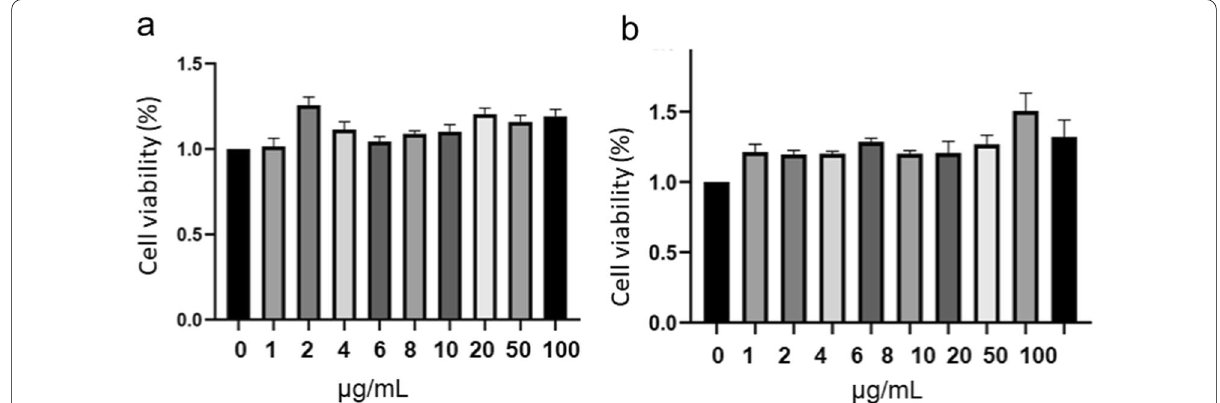
Fig. 5 Cell viability of PC12 in the presence of CDs ( a ) and CDFs ( b ). Cell viability (%) blank group)/(absorbance of the control group—absorbance of the blank group)